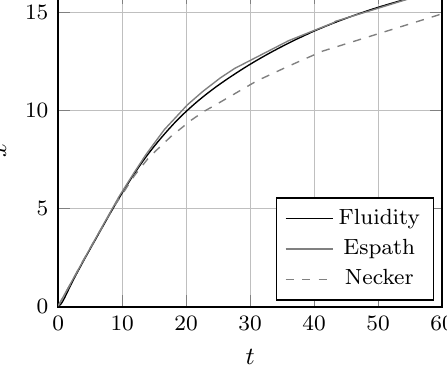
Figure 11. Position of density current head against simula- tion time for the Fluidity simulation and the simulations of Necker et al. (2002) and Espath et al.